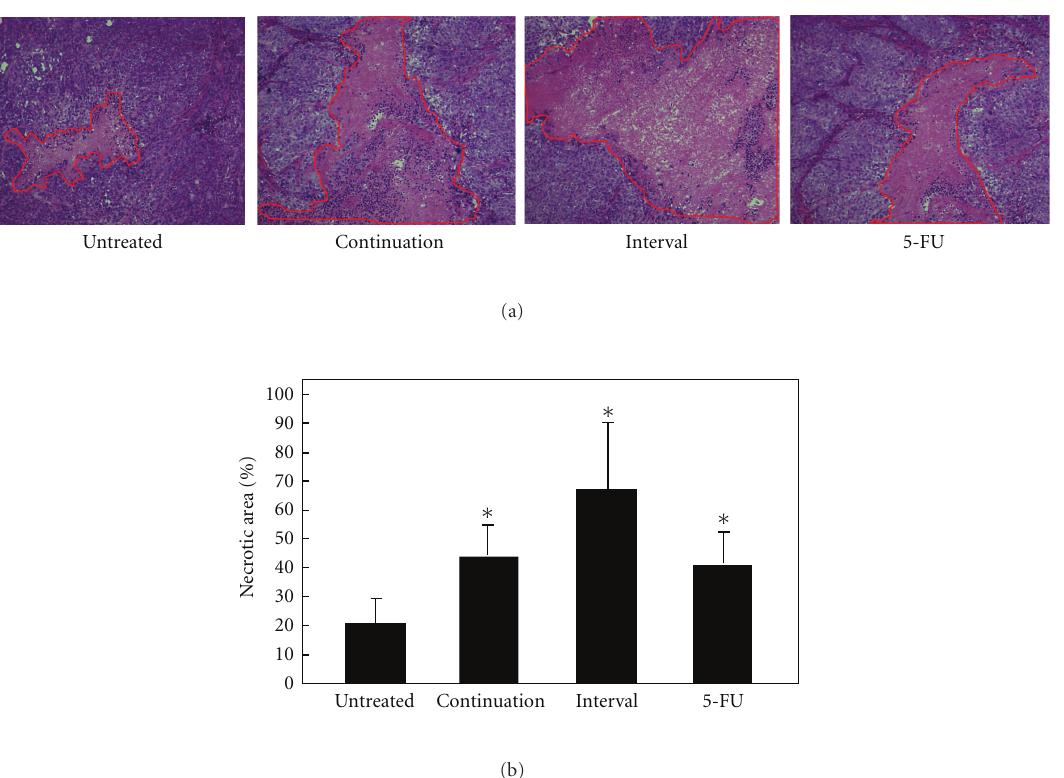
Figure 4: Pathological observation of the necrotic area of the xenografts. HE staining × 200. Representative examples of the necrotic area in the four di ff erent groups are shown (a). Necrotic area was calculated with Image-Pro Plus Version 4.5 (b). Standard deviations and P values were calculated with Student’s t -test ( P < .